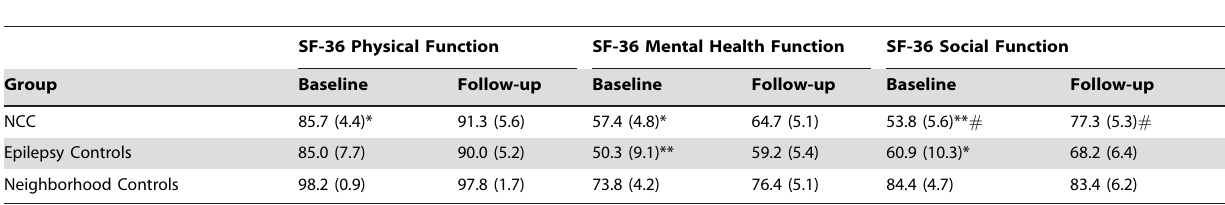
Table 4. SF-36 transformed scale scores for major quality-of-life outcomes at baseline and 6-month follow-up.